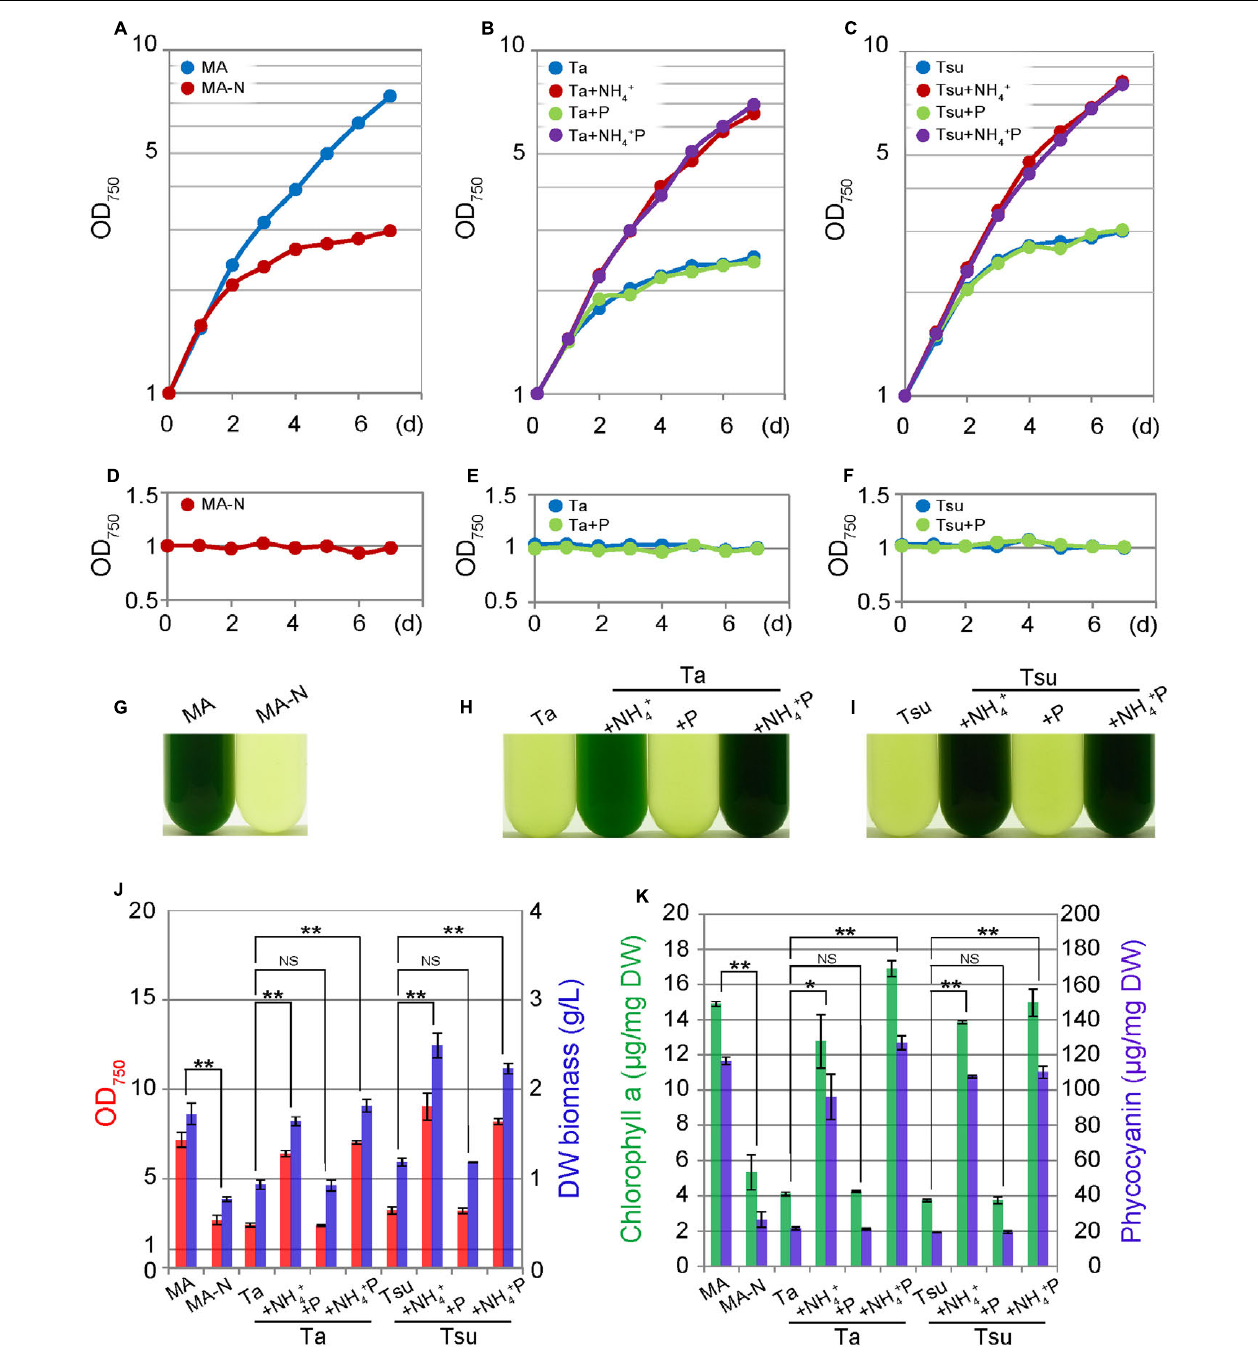
FIGURE 1 | Growth of G. sulphuraria 074G cells in synthetic MA, nitrogen-depleted MA-N and media derived from acidic hot spring waters. (A–C) Change in the OD 750 of the culture in the respective media. Cells cultured in synthetic MA medium (with an OD 750 of 1.0–2.0) were collected by centrifugation, resuspended into the respective media to give an OD 750 of 1.0 and then cultured for 7 days. (D–F) The change in the OD 750 of the culture in the respective media. Cells cultured for 7 days in each medium were again inoculated into the same medium. (G–I) Photographs of the cultures in the respective media at 7 days after inoculation. (J) OD 750 (red bar) and algal dry weight (DW biomass; blue bar) at 7 days after inoculation into the respective media after being taken from the MA medium. (K) Chlorophyll a (green bar) and phycocyanin (blue bar) contents per algal dry weight (DW) at 7 days after inoculation into the respective media after being taken from the MA medium. Three independent experiments showed similar results and the results from one experiment are shown (A–I) . The bar indicates the standard deviation of three independent experiments (J,K) . Significance was calculated by t -test. ∗ Statistically significant differences at P < 0.05; ∗∗ statistically significant differences at P < 0.01; NS, not significant (J,K)